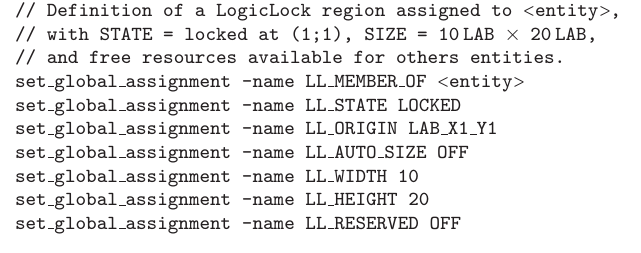
Figure 10: Example of TCL script setting up a LogicLock region.